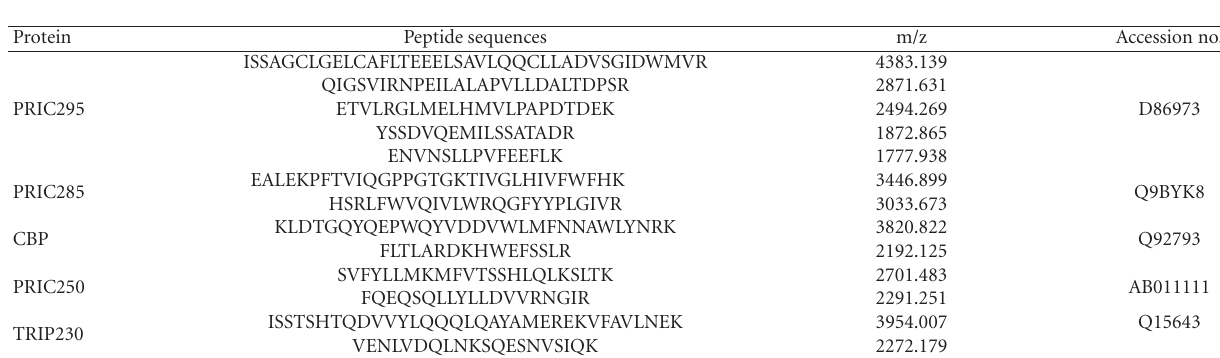
Figure 1: PRIC295 in ciprofibrate bound protein complex. (a) Ciprofibrate-binding protein complex isolated from rat liver nuclear extracts analyzed on a 3%–8% Tris-acetate silver stained gel. Lane 1 marker; lane 2 BP, binding proteins. Selected high molecular weight bands (arrows) were excised from the gel and digested with trypsin. MALDI-TOF analysis was conducted on the marked bands yielding peptide- matching protein identities, in descending order from highest molecular weight to lowest, of PRIC295, PRIC285, CBP, PRIC250, and TRIP230. (b) Mass spectrometric and limited sequence analysis data of proteins identified by MALDI-TOF with their associated peptide fragment sequences, m/z ratios and corresponding accession